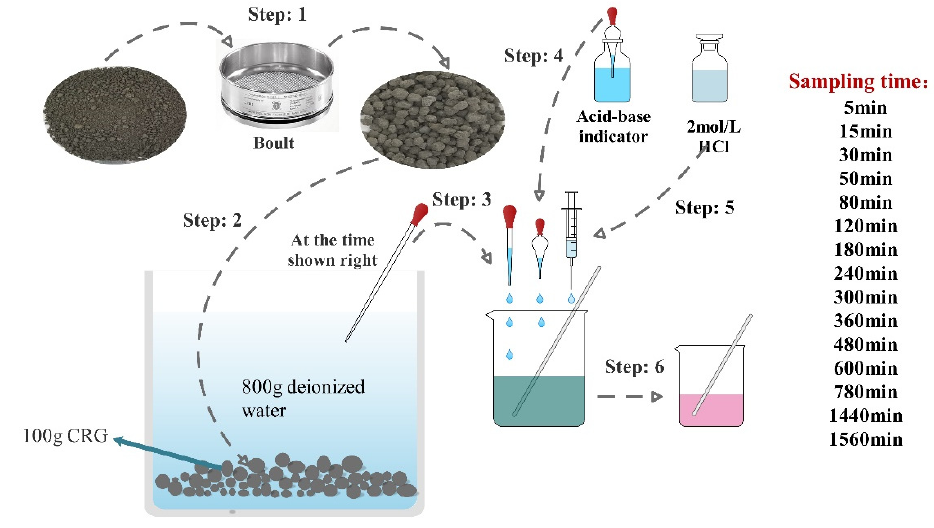
Figure 4. The flow chart of the titration test.